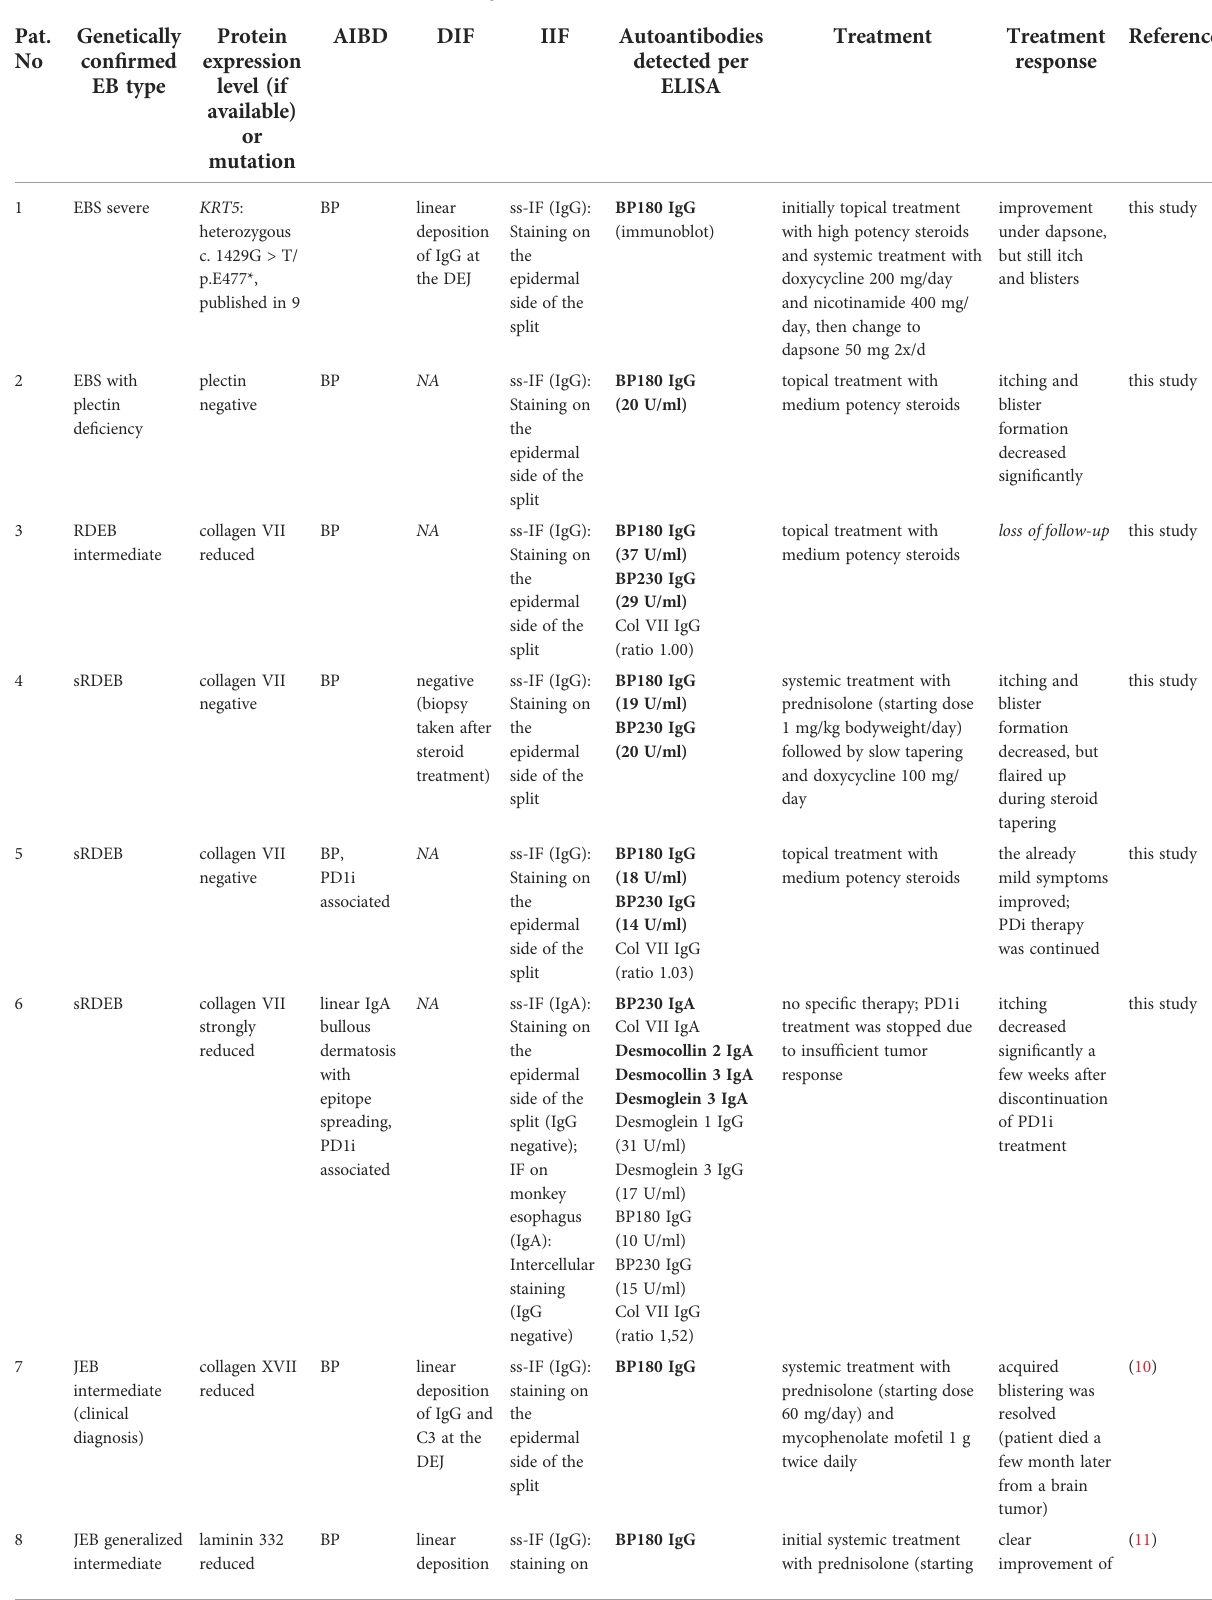
TABLE 1 Patients with EB and AIBD described in this study and in the literature. Pat.